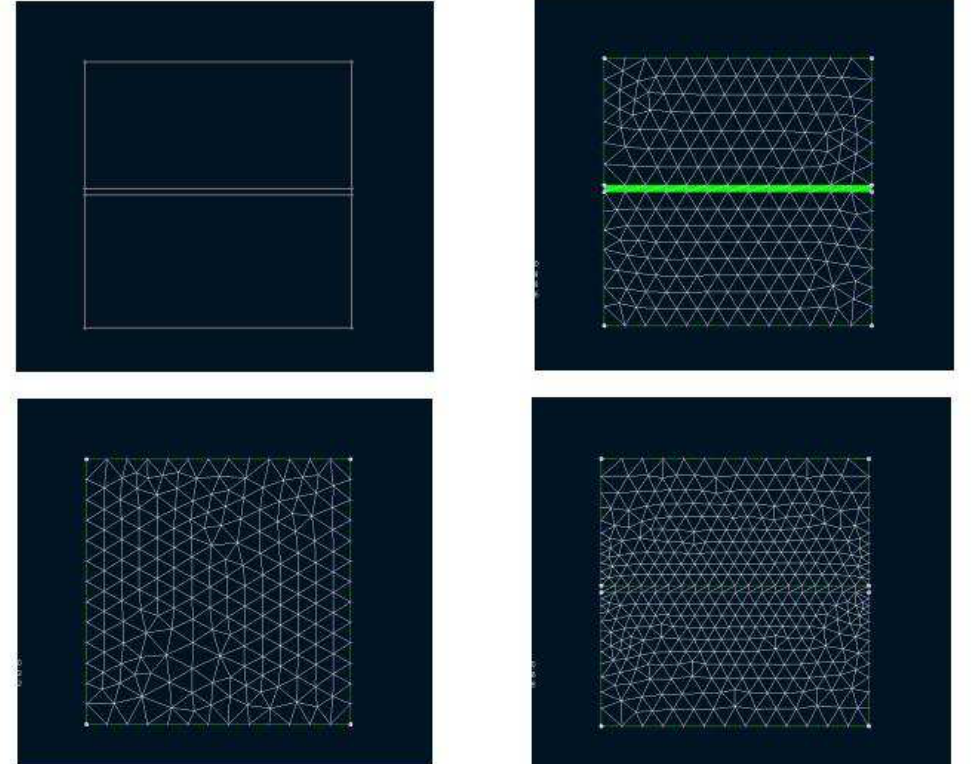
Figure 4 Geometrical Detail causing highly skewed elements